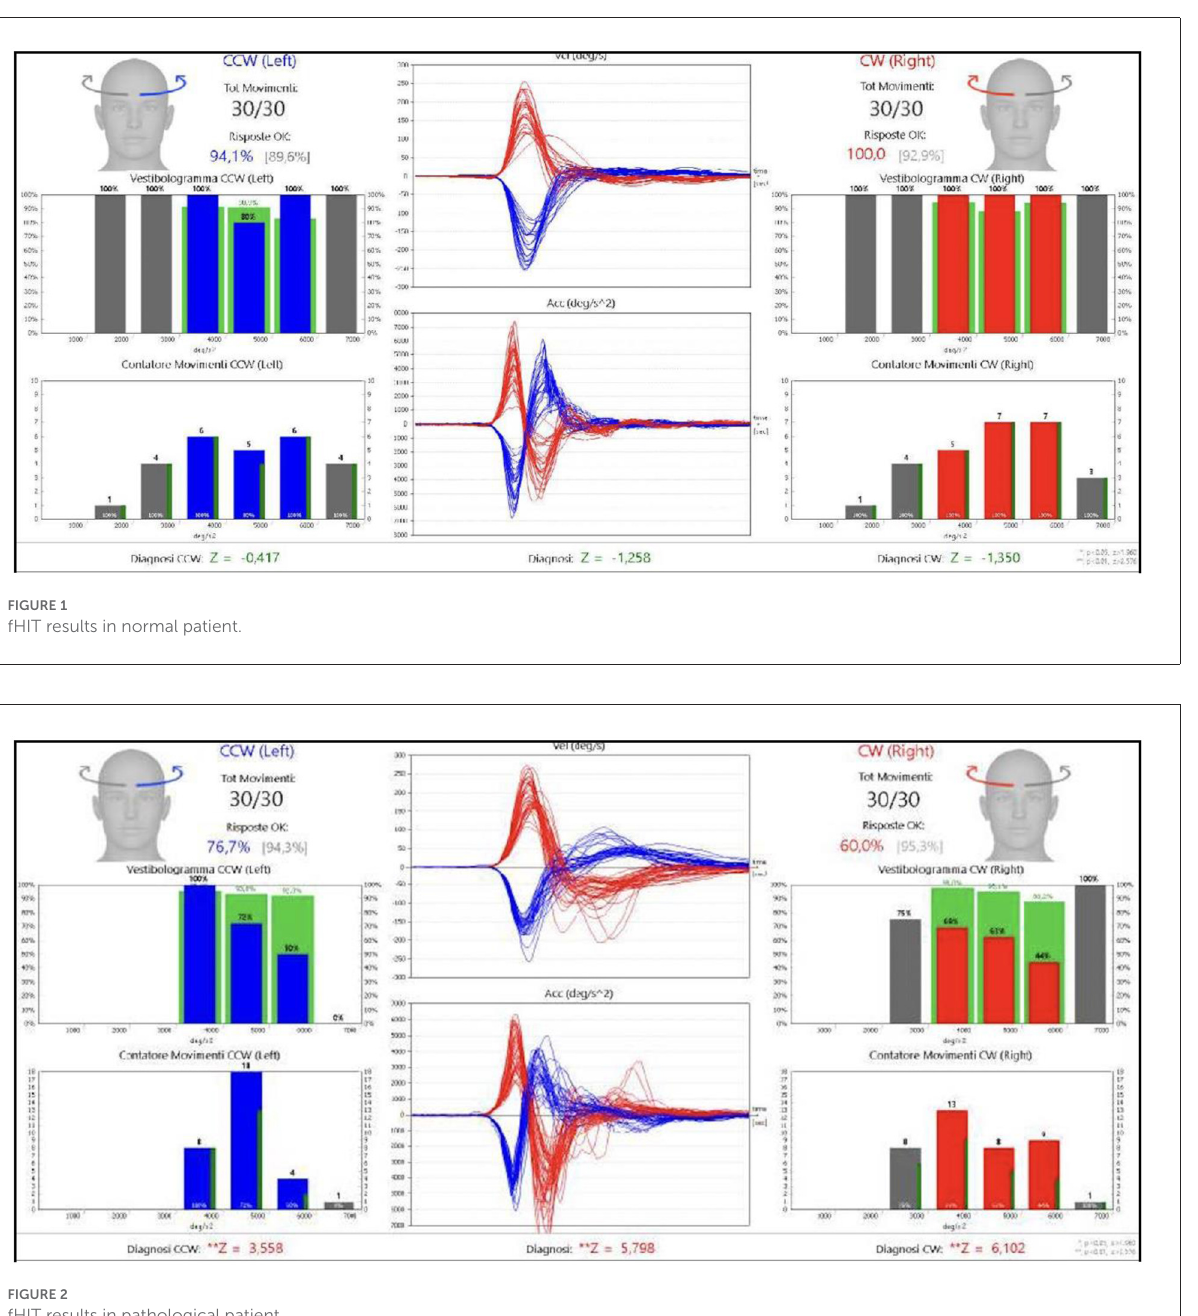
FIGURE2 fHIT results in pathological